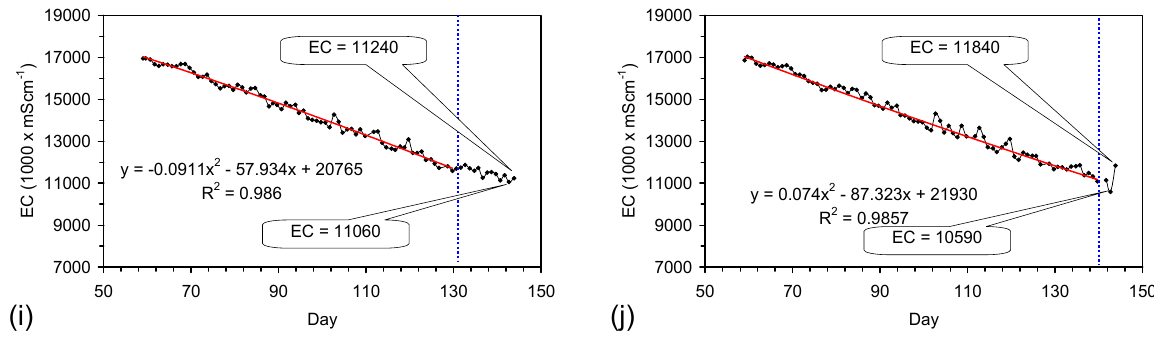
Figure D5. Feed Water EC = 16.960 mS·cm − 1 . ( a ) S4:T1; D = 0.0055; R 2 =